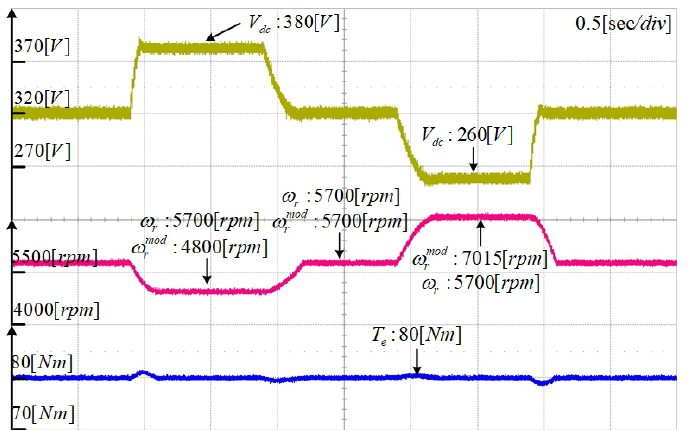
Figure 9. Constant torque control using proposed method during DC-link voltage